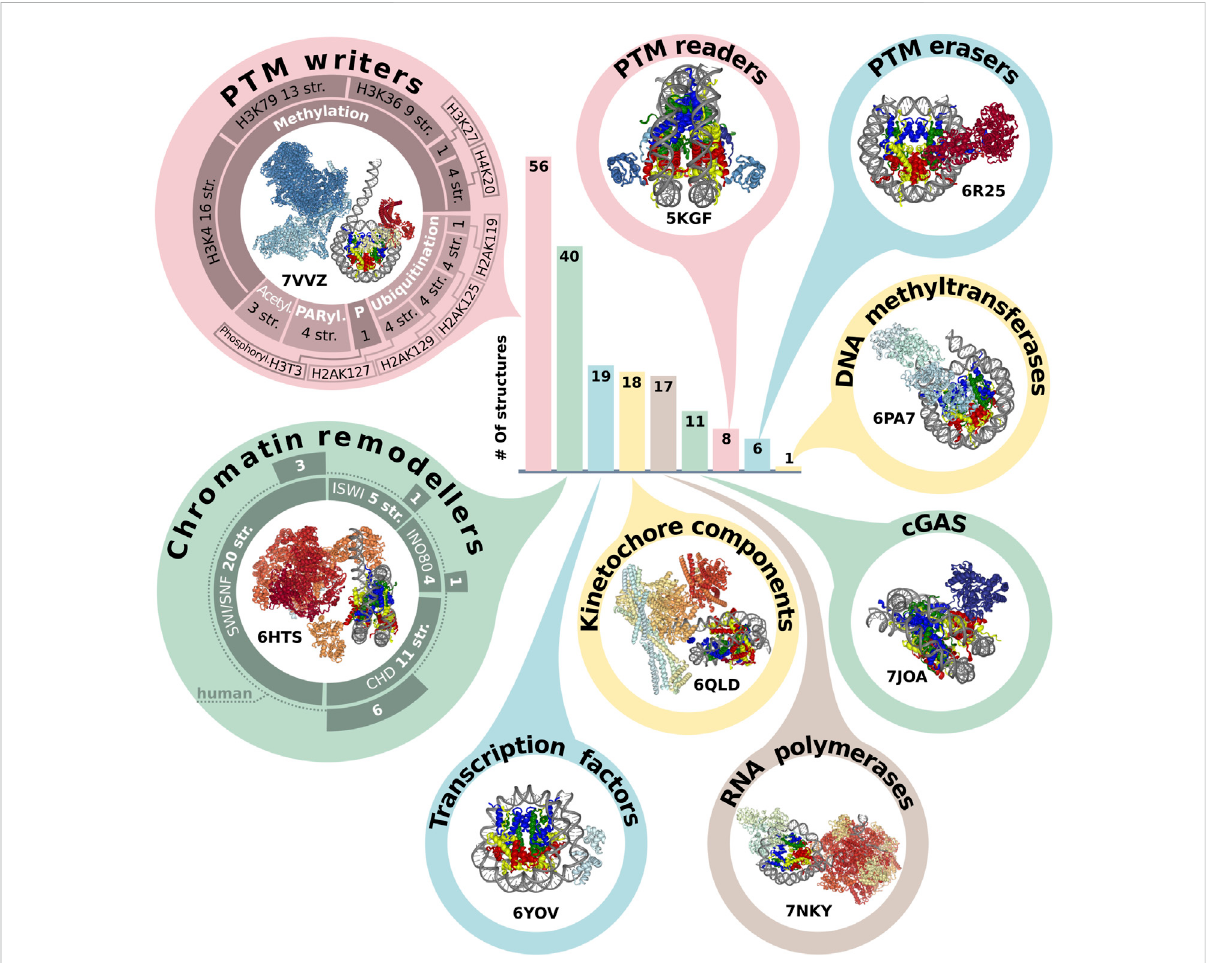
FIGURE 2 Representation of NCP in protein complexes. The bar plot indicates the number of structures annotated by the molecular functions (see text). The structures of class representatives are depicted in circles with PDB IDs. The panel around PTM (post-translational modi fi cation) writers representsanumberofstructuresassociatedwithmodi fi cation(methylation,ubiquitination,acetylation,PARylationandphosphorylation)ofspeci fi c sites. The panel around chromatin remodelers represents the number of structures in the chromatin remodeler family, which are additionally subdivided into human and non-human complexes. The infographic does not include the following categories: Histone chaperone (three structures), Histone exchange (two structures), DNA integration (two structures). The PDB IDs for each protein category are presented in Supplementary Table